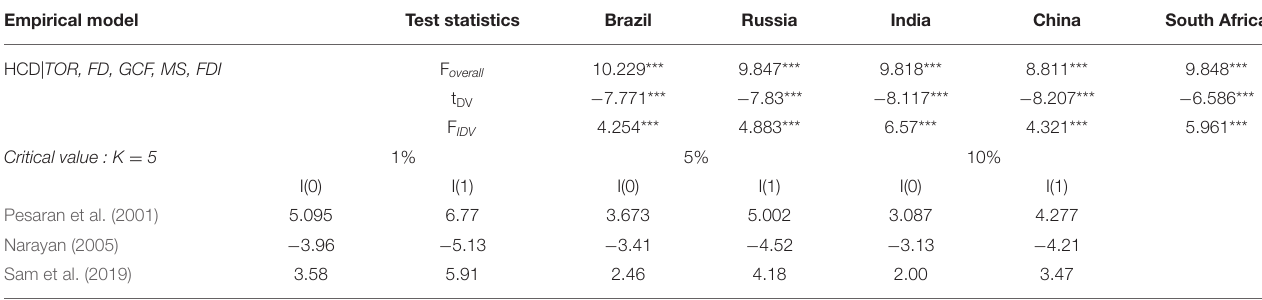
TABLE 6 | Augmented Autoregressive Distributed Lagged (AARDL) cointegration test. Empirical model